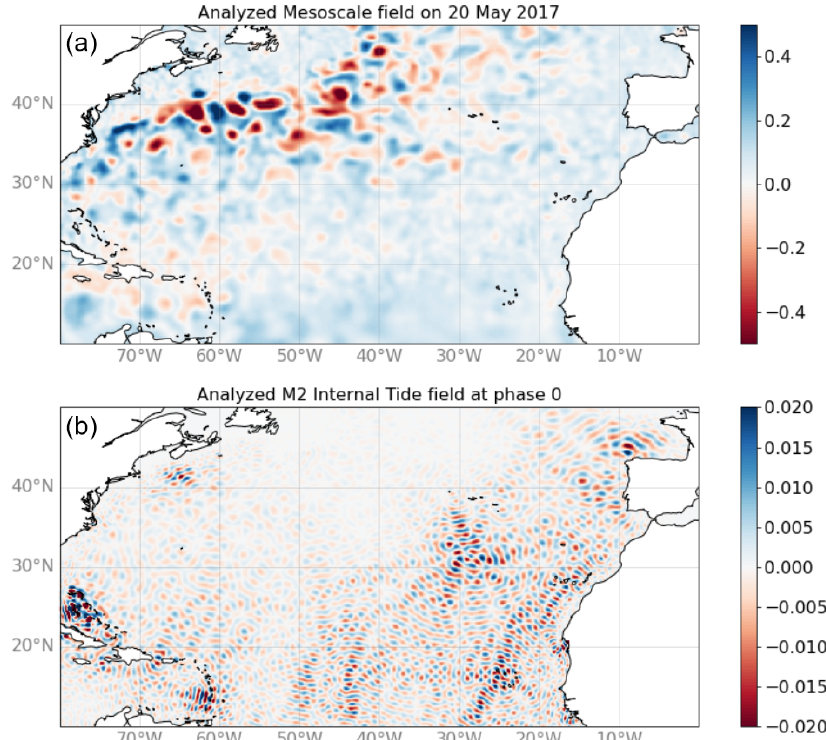
Figure 6. Snapshots of the reconstructed solutions in sea surface height (m) for 20 May 2017 at 00:00UTC in the North Atlantic basin, for the mesoscale component (a) and for the internal tide component (b).